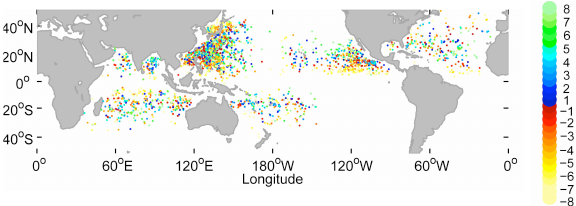
Figure A2. Locations of TC-affected Argo pairs with colors show- ing the cross-track distances of their locations relative to the cor- responding storm track. Positive values indicate pairs to the right (left) side of the track in the Northern Hemisphere (Southern Hemi- sphere).